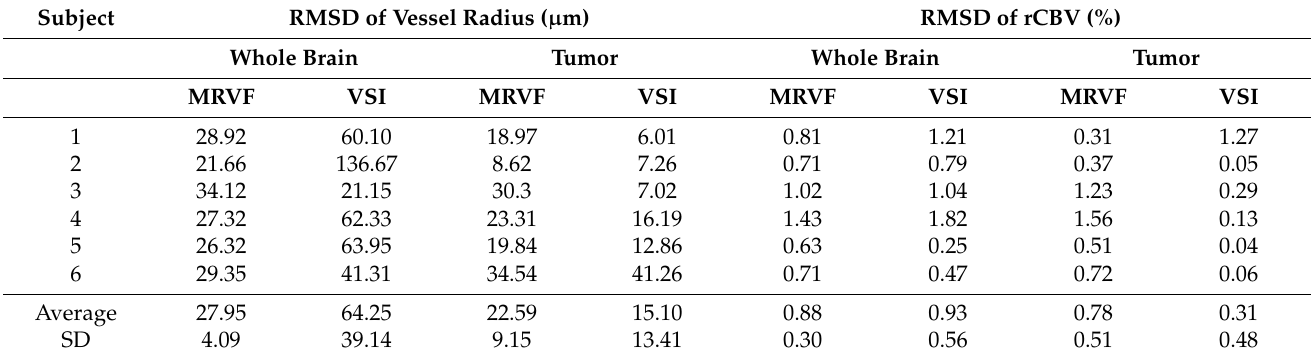
Table 4. Root mean square deviations (RMSDs) calculated for the whole brain and tumor regions between the vessel radius (in µ m) and rCBV (in %) maps obtained from the raw and noisy datasets for the MRVF and VSI techniques. The average and SD of the RMSD for each parameter and technique among the 6 subjects are also